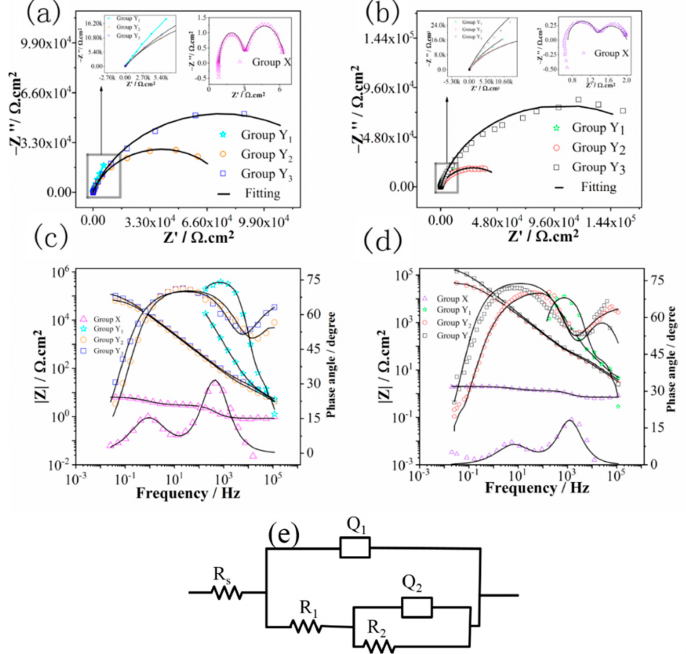
Figure 6. Electrochemical impedance spectroscopy (EIS) plots of groups X, Y 1 , Y 2 and Y 3 at 100 ± 5 ◦ C in 4 M HCl and 4 m H 2 SO 4 ; ( a , b ) Nyquist plots; ( c , d ) bode plots; ( e ) equivalent cir- cuit